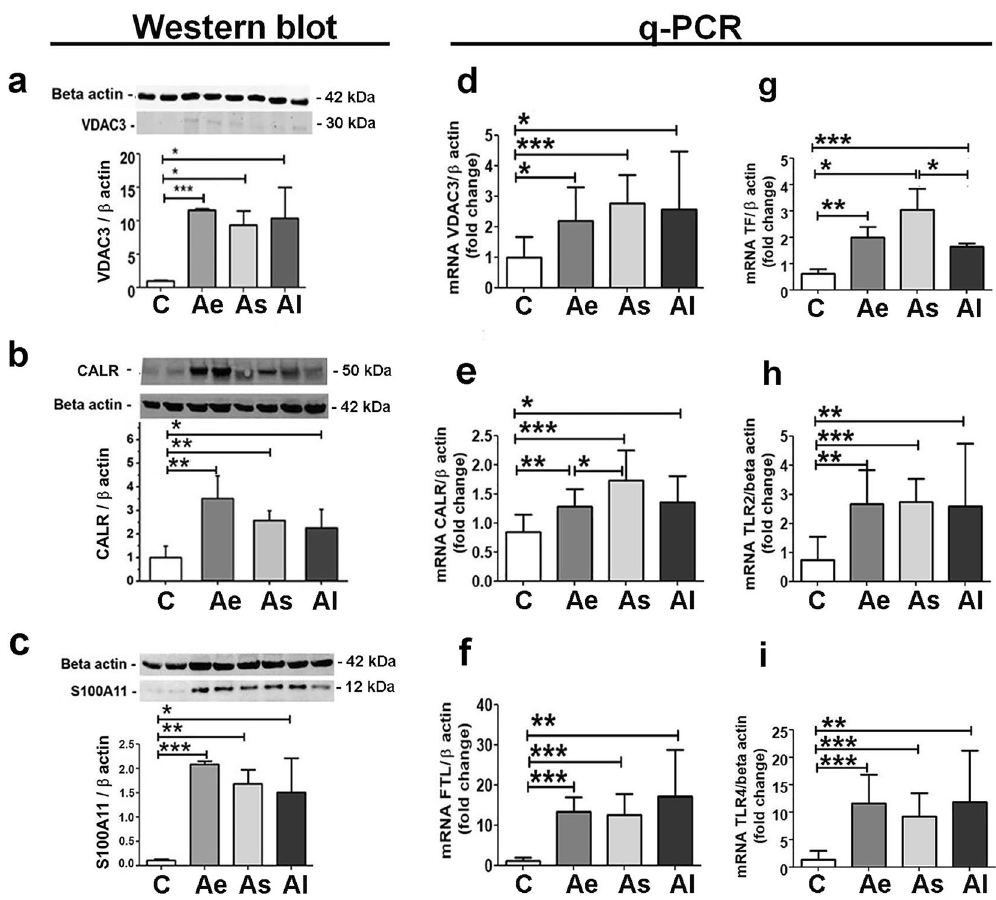
Figure 6. Validation of mass spectrometry data by Western blot and quantitative qPCR methods. The Western blot immune detection and associated densitometry for selected protein markers: ( a ) VDAC3, ( b ) CALR and ( c ) S100A11 and mRNA gene expression level for: ( d ) VDAC3, ( e ) CALR, ( f ) FTL, ( g ) TF, ( h ) TLR2 and ( i ) TLR4 in aortic homogenate prepared from C, Ae, As and Al groups normalized to beta actin protein and gene expression, respectively. C: Control group, Ae: early atherosclerotic group, As: statin and PCSK9 antibody stabilized atherosclerotic group and Al: late atherosclerotic group. Protein and gene levels found for the selected markers are in good corroboration with the mass spectrometry results. Statistical analysis was performed using t Student’s test and results show mean ± SD (* p < 0.05; ** p < 0.01 and *** p < 0.001; n > 4). VDAC3: voltage- dependent anion-selective channel protein three, CALR: calreticulin, S100A11: protein S100A11, FTL: ferritin light chain, TF: transferrin, TLR2: toll like receptor 2 and TLR4: toll like receptor 4. The original blots images of the membranes from this figure can be found in Supplementary